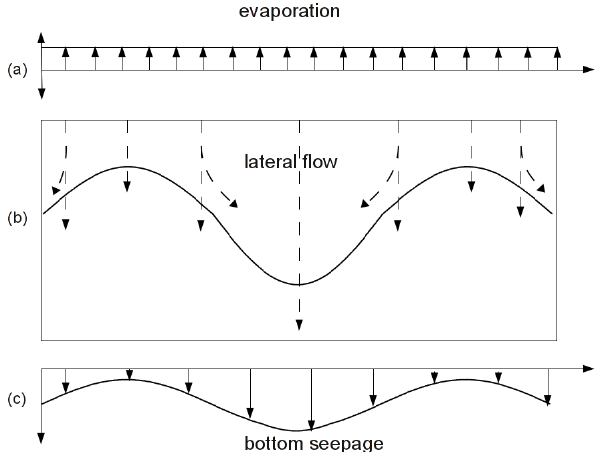
Fig. 11. Schematic of the proposed spatial soil water dynamics in a soil with dune-deposit structure. (a) Major processes at the surface; (b) soil water redistribution in the soil; (c) bottom seepage through the dune interface.